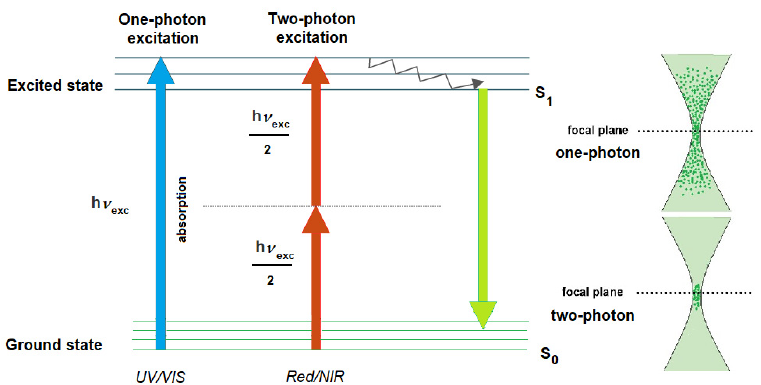
Figure 6. Simplified Jablonski diagram of OP and TP activation (adapted from Klausen and Blanchard-Desce [51]).